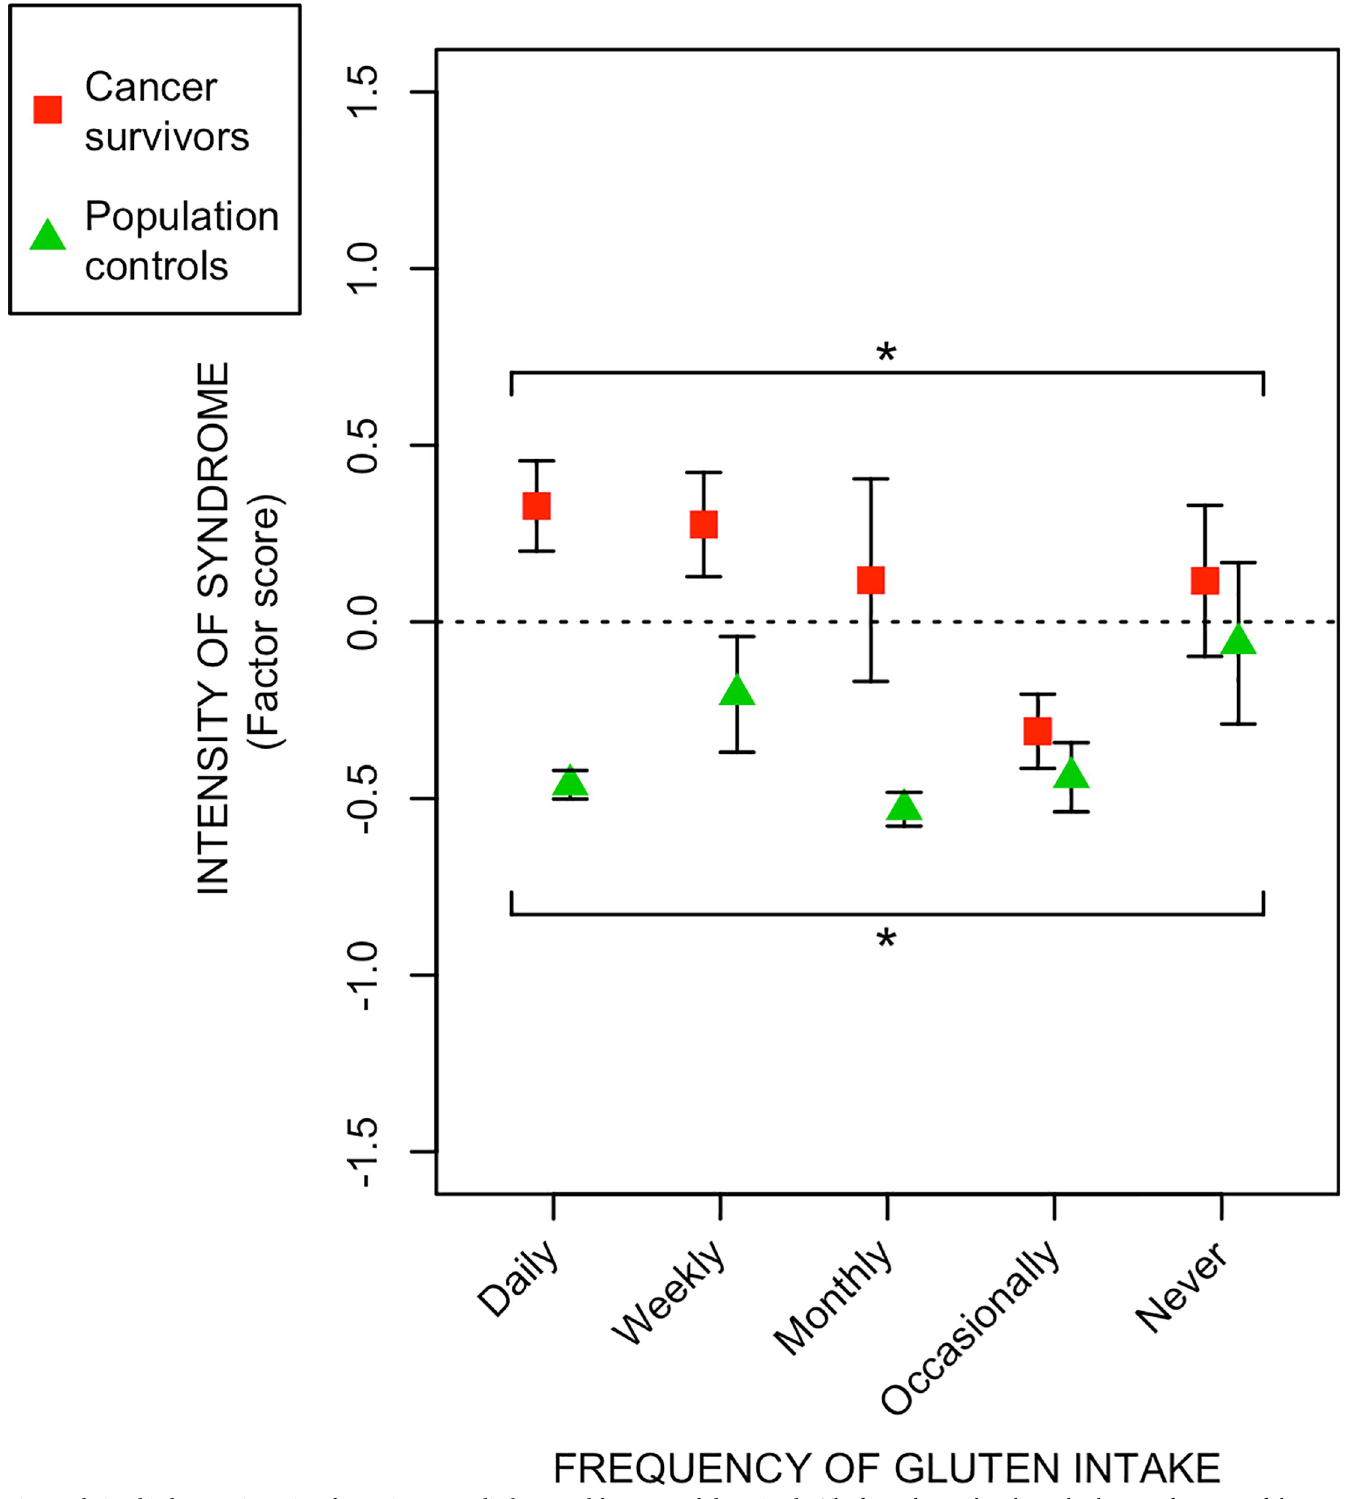
Fig 3. Relationship between intensity of excessive mucus discharge and frequency of gluten intake. The figure depicts the relationship between frequency of gluten intake (x-axis) and the intensity (factor scores) of the radiation induced syndrome (y-axis) excessive mucus discharge among long-term gynecological cancer survivors and population controls. Red squares/green triangles denote the mean syndrome intensity within certain gluten intake frequency levels. Vertical black lines stretch